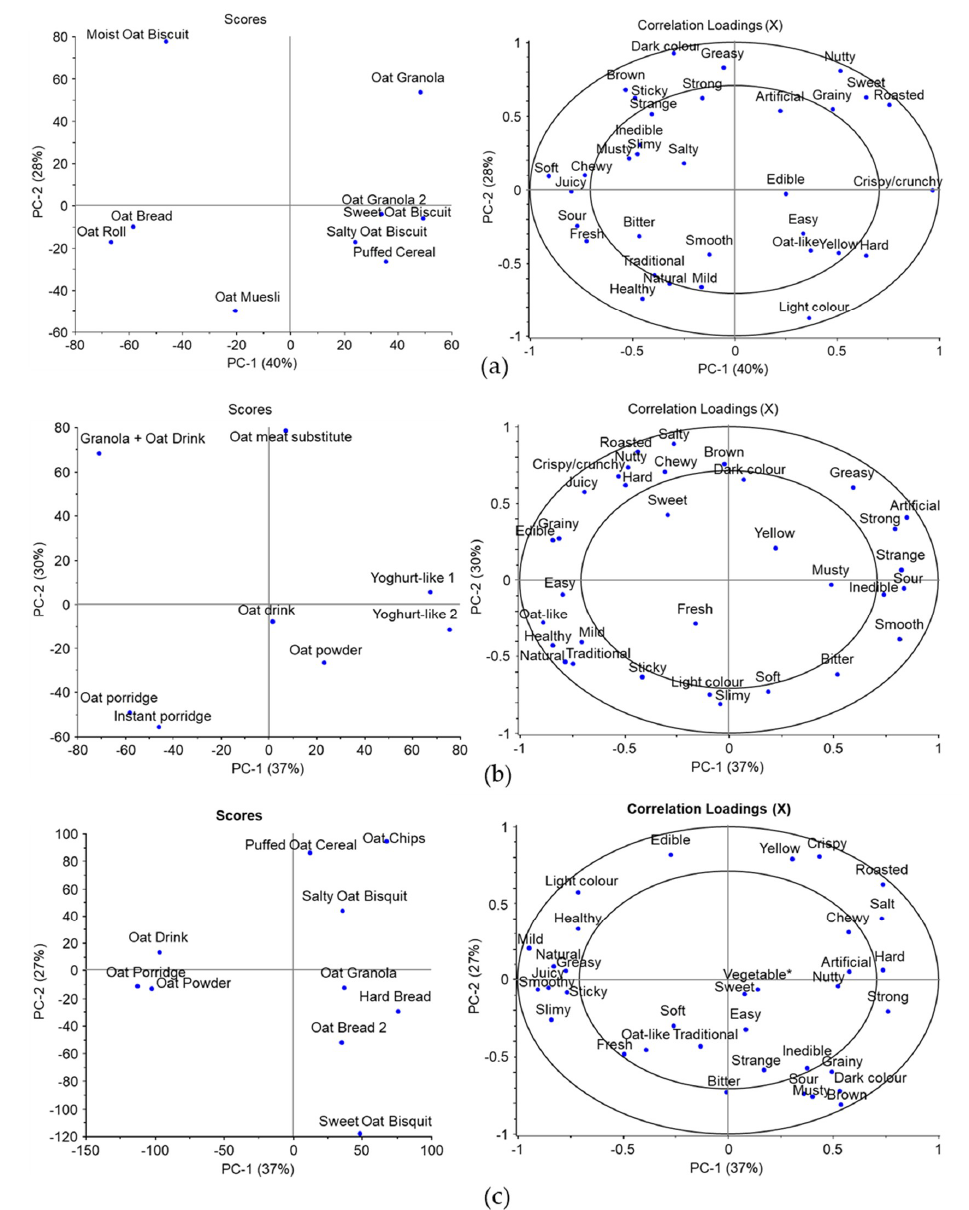
Figure 1. Principal component analysis models based on the Check-All-That-Apply (CATA) attributes used to describe the oat samples in the three sensory tests (Table 1). ( a ) Scores and loadings plots for samples evaluated in study 2; ( b ) samples evaluated in study 3; ( c ) samples evaluated in study 4. Only attributes selected by a minimum of 5% of the panels were used in the models.